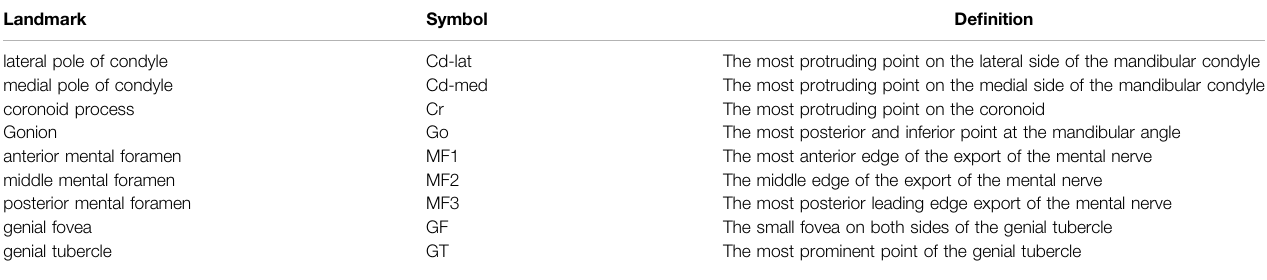
TABLE 1 | A total of 17 anatomical landmarks on the mandible were used as validation points to monitor the 3D morphological changes of the mandibular surface during growth.